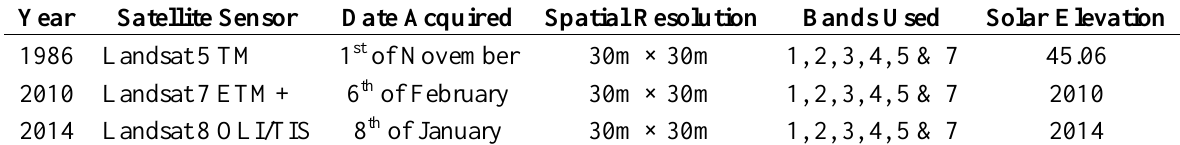
Figure 7. The Landsat ETM/ETM+ Satellite Images for ( a ) 1986, ( b ) 2010 and OLI/TIS Image of ( c ) 2014 respectively, used in the classification of the LULC types. Table 8. Satellite images characteristics.